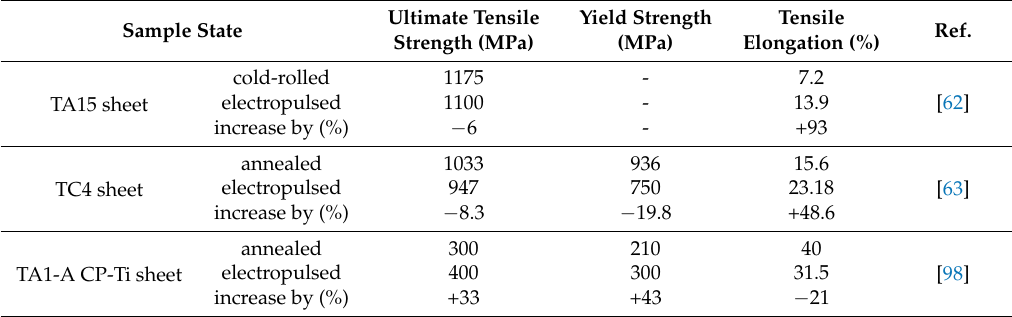
Table 1. Mechanical properties of pure titanium and titanium alloys before and after